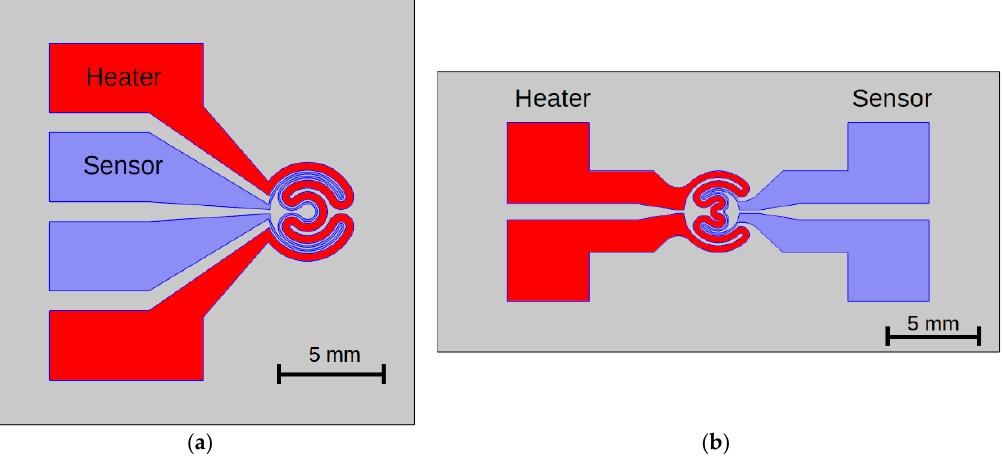
Figure 3. Geometry of heater-sensor structures: ( a ) structure with one-sided leads; ( b ) structure with two-sided leads .